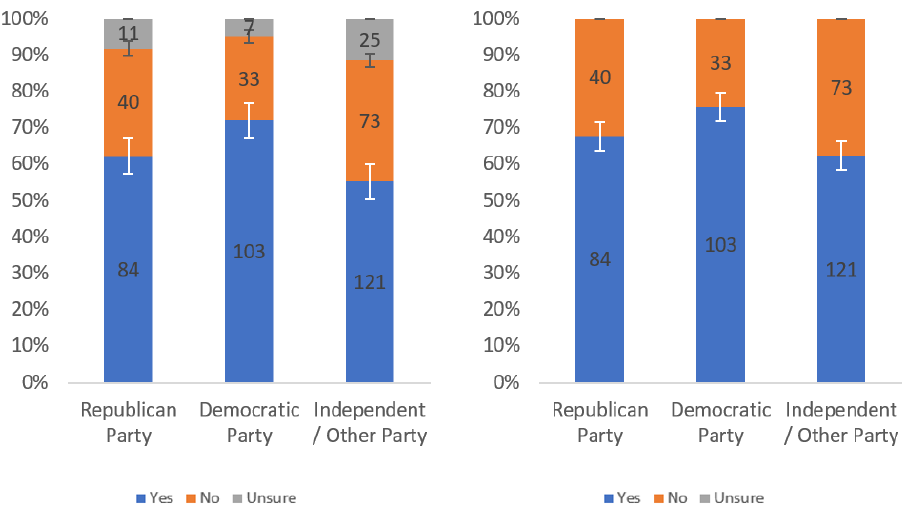
Figure 40. Responses regarding label helpfulness by party affiliation including ( left ) and excluding ( right ) unsure responses.